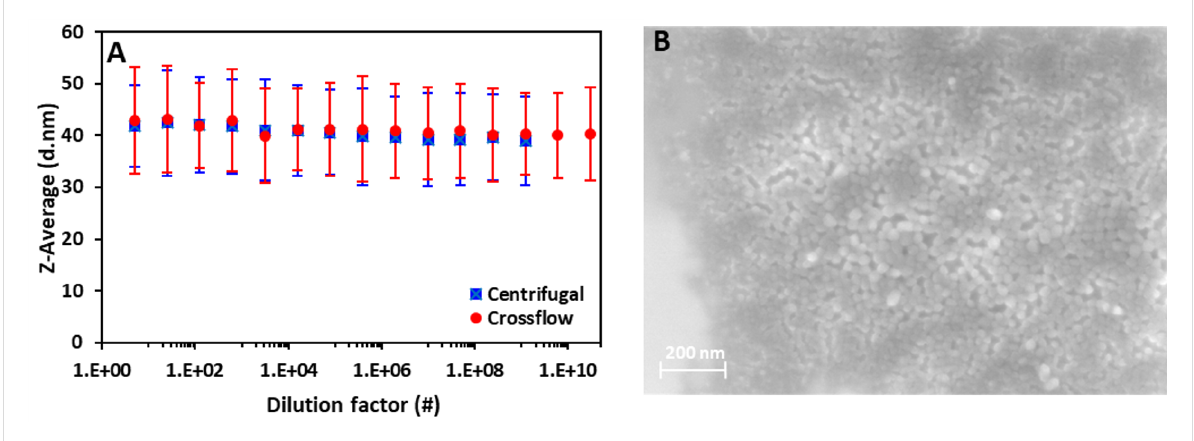
Figure 1: (A) The Z -average size of poly(3-hexylthiophene) (P3HT):indene-C 60 multiadducts (ICxA) NPs dialysed by crossflow and centrifugal ultrafil- tration processes vs varying dilution factor. The error bars makes the standard deviation in particle size for the particle population in the sample. (B) SEM image of P3HT:ICxA